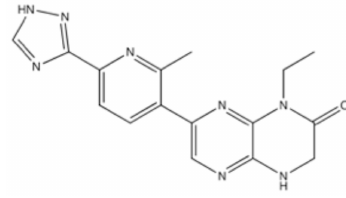
Figure 11. Structure of